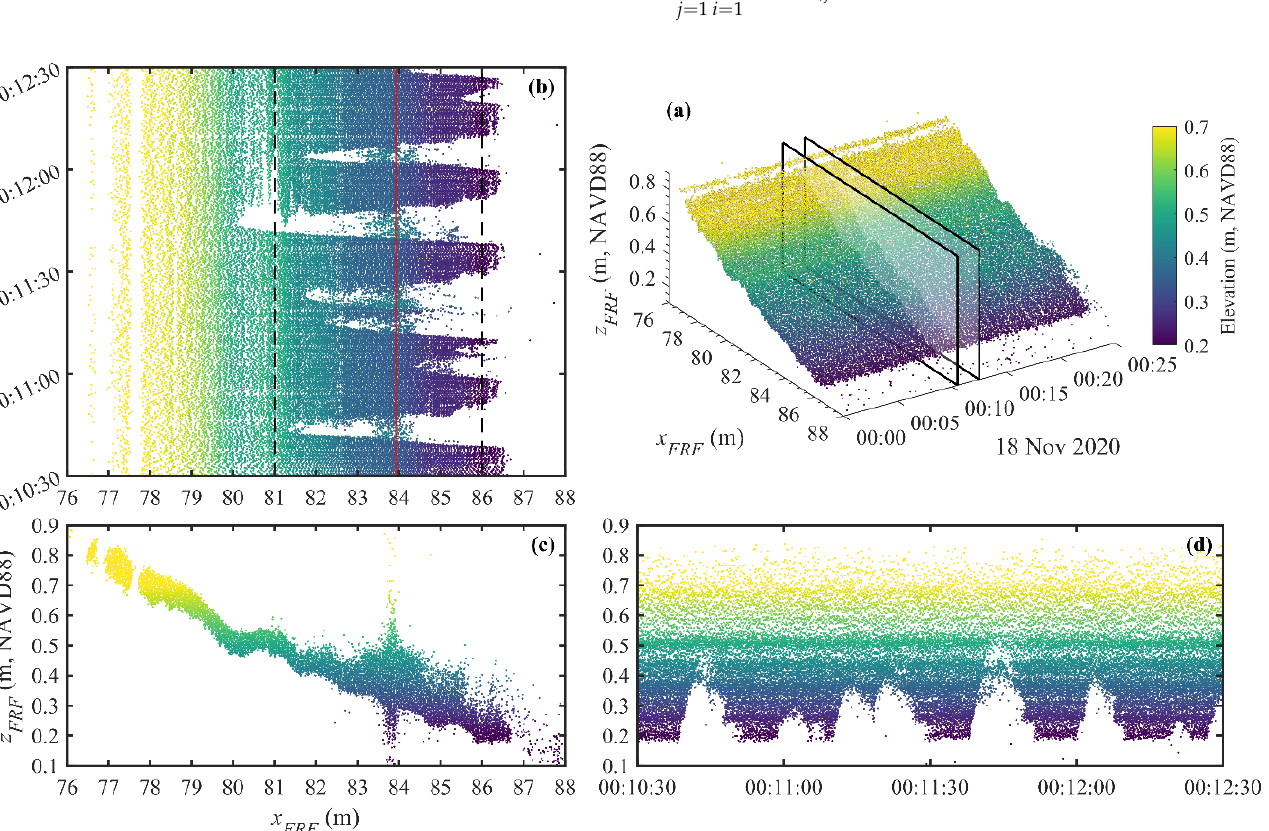
Figure 6. ( a ) Georectified point cloud time stack from a 25-minute continuous LLC LiDAR scan during Series C (18 Nov 2020), with zoomed-in 2-minute time stacks of scan data from three different perspectives: ( b ) plan view, ( c ) profile view, and ( d ) front view. The transparent surfaces in ( a ) mark the time bounds for the point clouds displayed in ( b )–( d ). The thick red line in ( b ) represents the cross-shore location of the LLC LiDAR puck (i.e., the nadir). The dashed black lines in ( b ) indicate the cross-shore range with suitable point density for the detection of wave runup with the LLC LiDAR. Times in UTC.